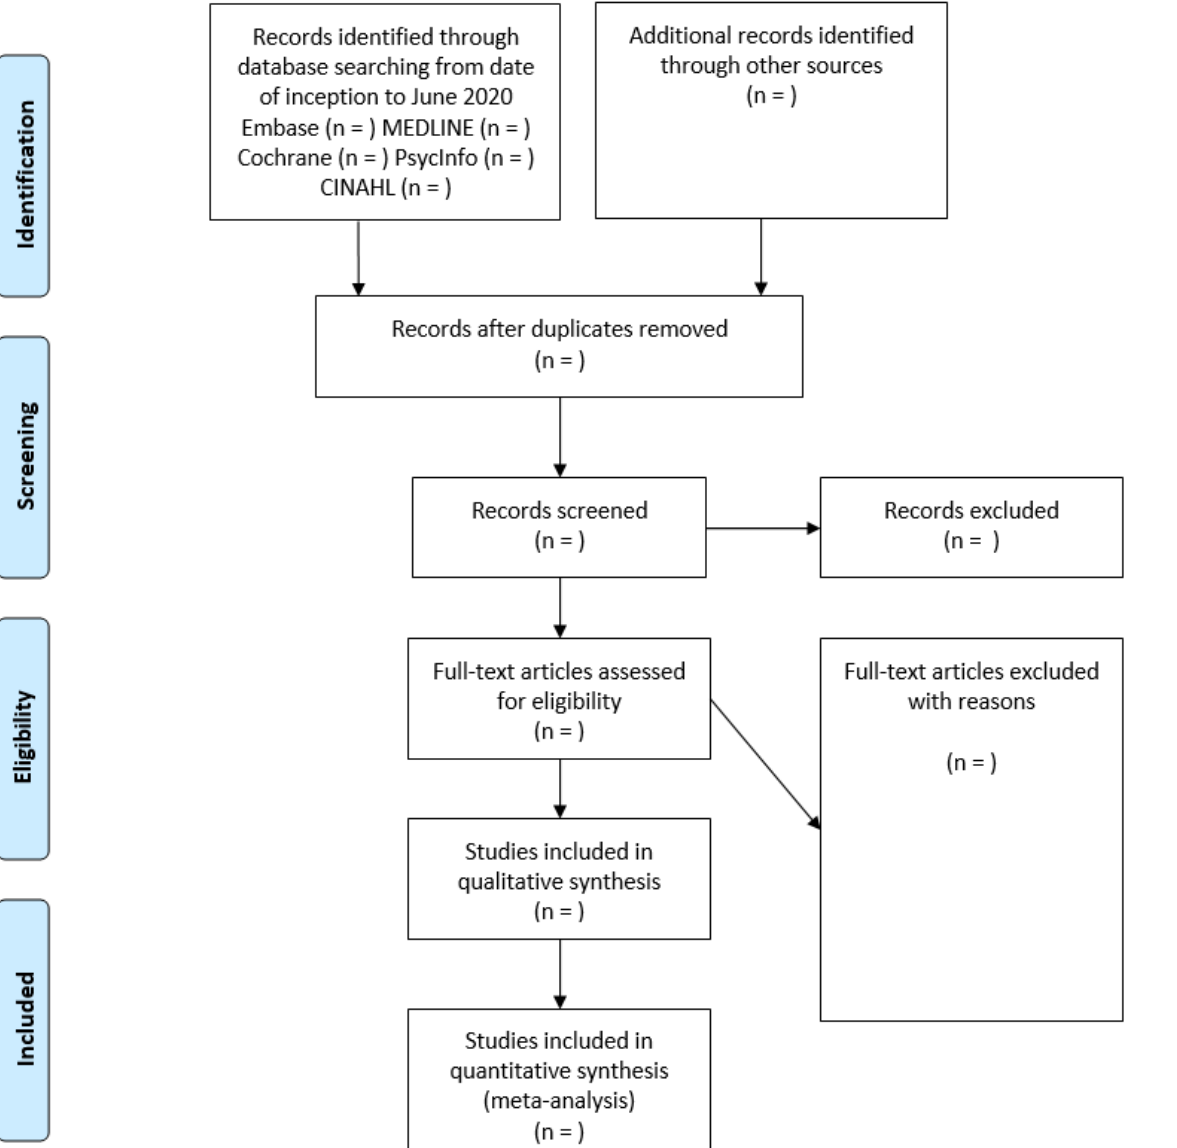
Figure 1. PRISMA flow diagram of study selection. PRISMA: Preferred Reporting Items for Systematic Reviews and